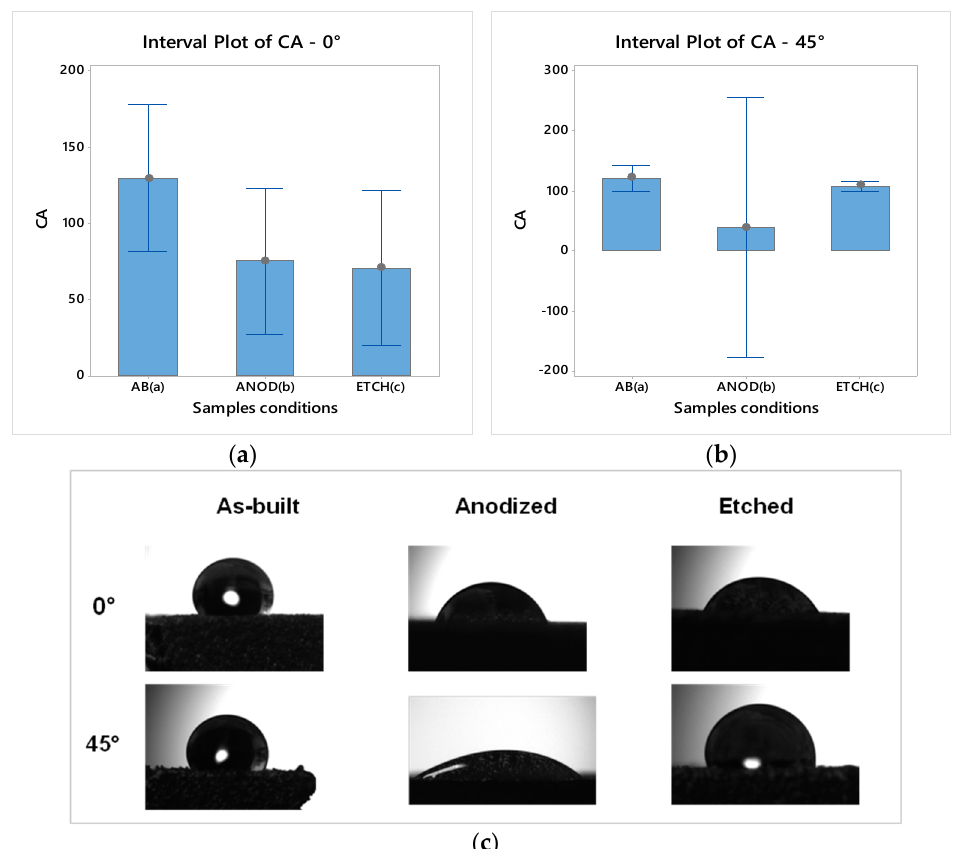
Figure 2. CA measurements for the samples: ( a ) 0° building angle individual samples; ( b ) 45° building angle individual samples; ( c ) images of the water droplets on the top surfaces at different building angles and treatments.